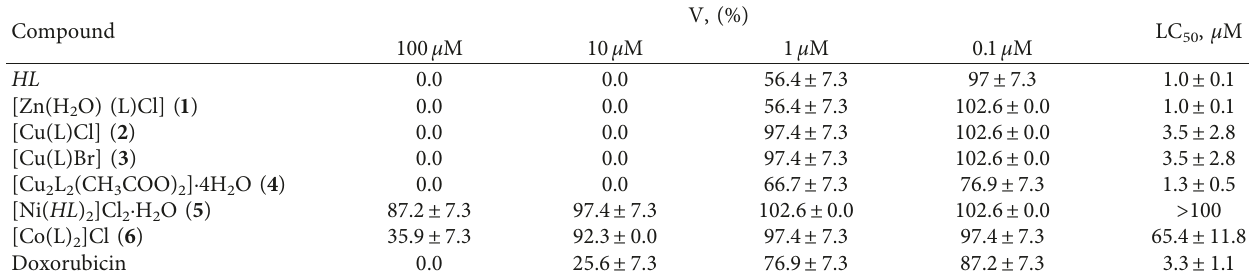
Table 5: The percentage of viability (V) of Daphnia magna in the presence of different concentrations of studied compounds and the corresponding LC 50 values.